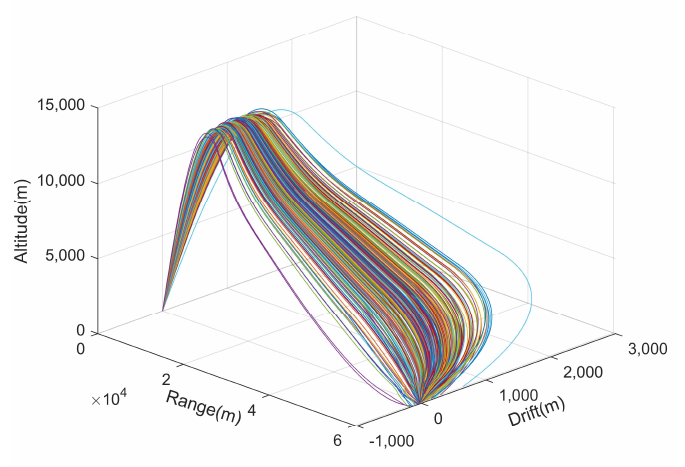
Figure 24. Guided Rocket Trajectories.